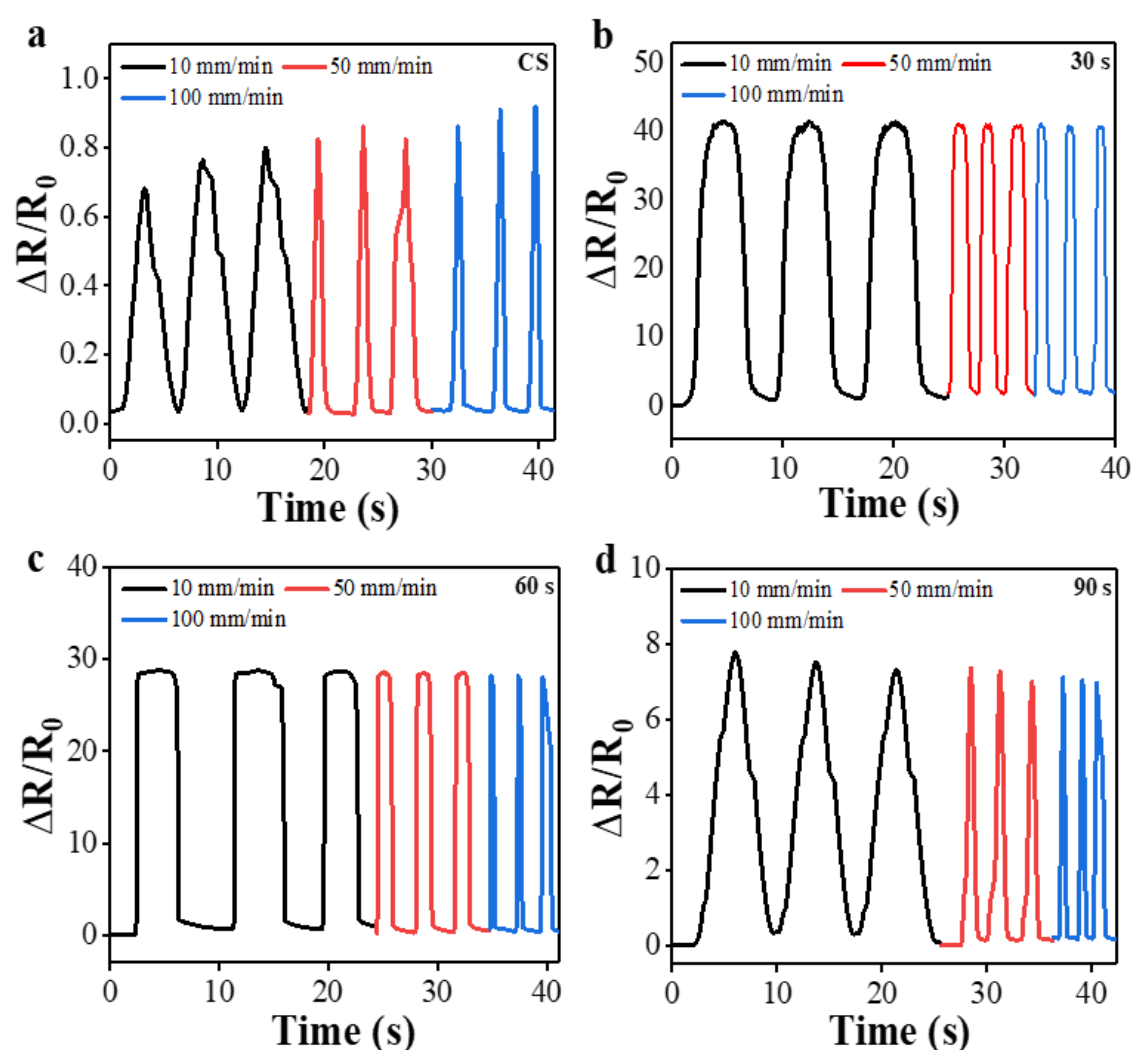
Figure 7. Normalized resistances measured under the different strains rates of 10, 50, and 100 mm/min at a constant strain of 20% from the PPy/PDMS strain sensors fabricated with various PT time intervals of ( a ) 0 (CS) and ( b ) 30, ( c ) 60, and ( d ) 90 s.